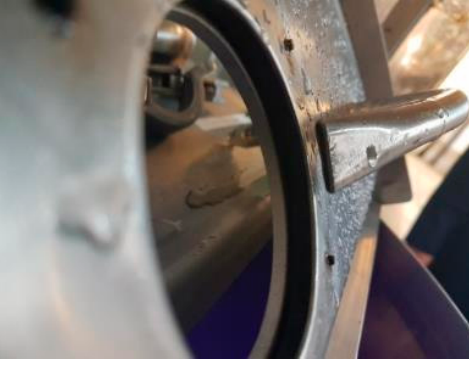
Figure 4. Air knife.